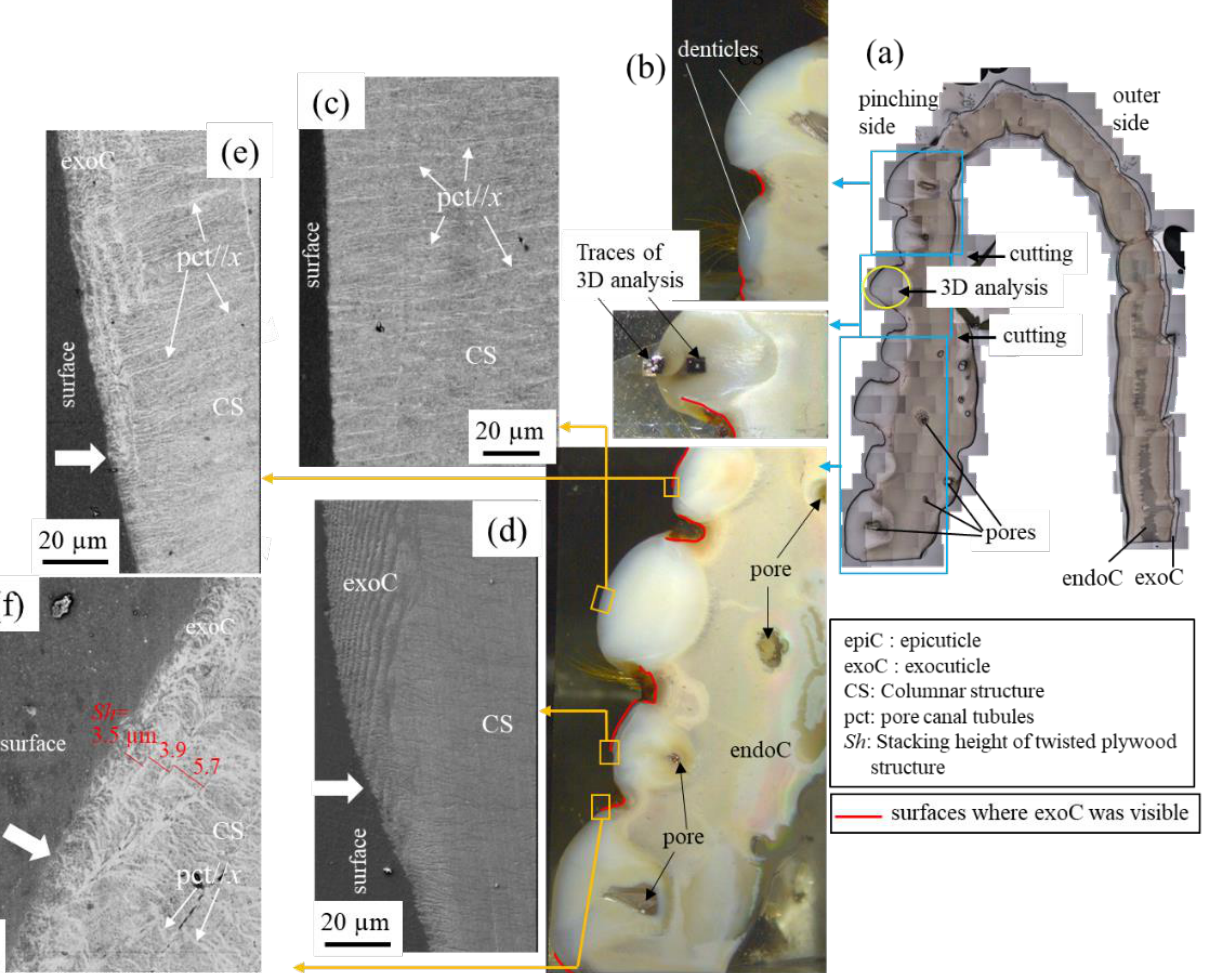
Figure 7. ( a ) Optical micrographs of a cross section of the fixed finger after polishing [20] and the cutting positions; ( b ) optical micrographs of the entire surface part of the pinching side. ( c – f ) SEM micrographs of the denticle surface with and without the exocuticle layer. Here, the white arrow denotes the position where the exocuticle disappeared on the denticle surface.